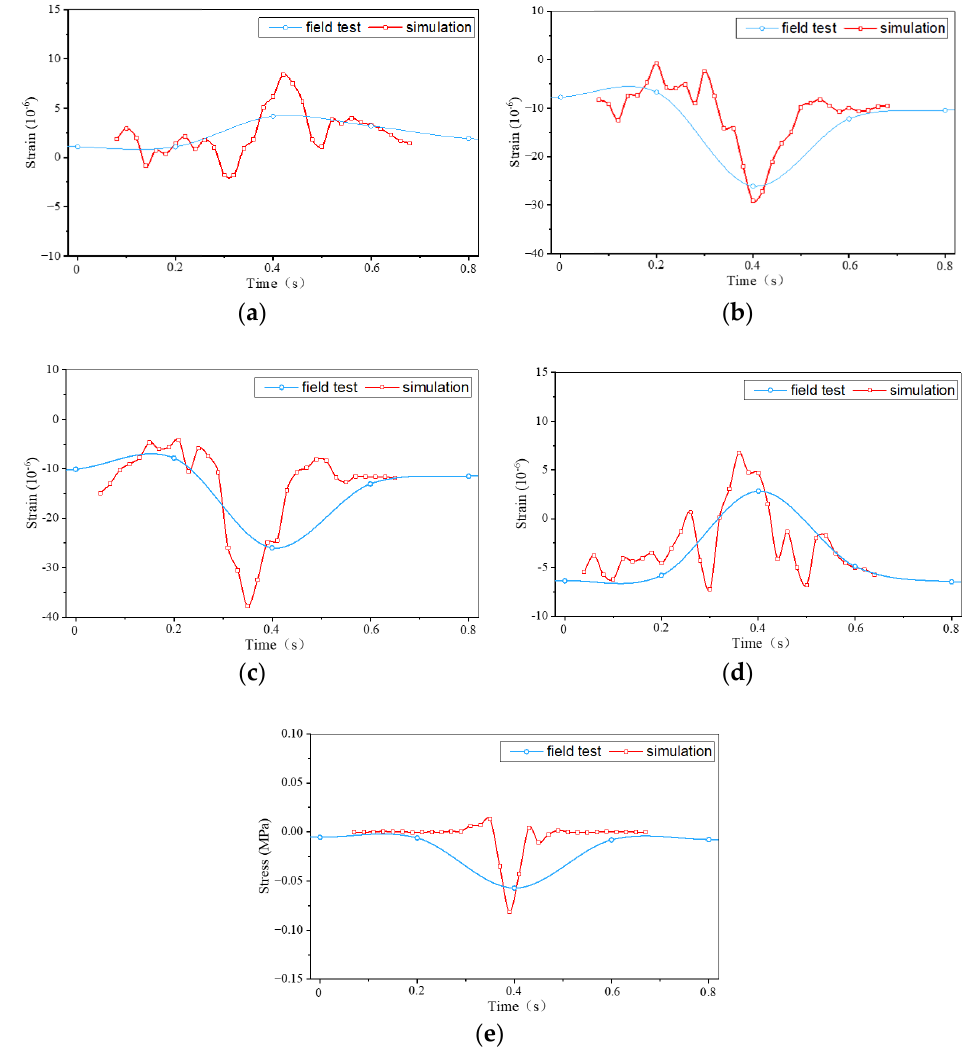
Figure 9. The measured dynamic responses of ART pavement verses simulated value. ( a ) The longitudinal strain at the bottom of SFP layer. ( b ) The transverse strain at the bottom of SFP layer. ( c ) The longitudinal strain at the bottom of AC layer. ( d ) The transverse strain at the bottom of AC layer. ( e ) The vertical stress at the bottom of AC layer.